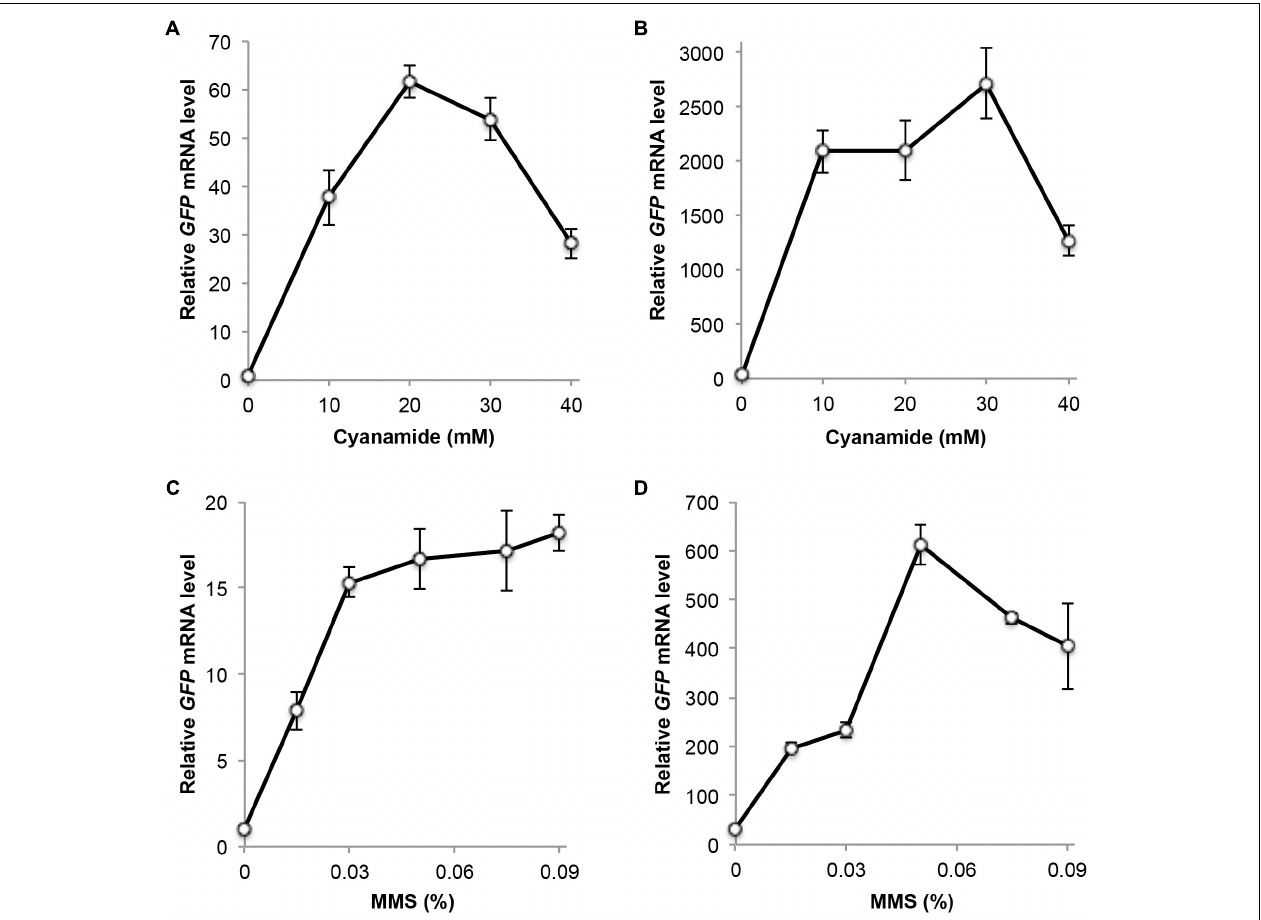
FIGURE 3 | Relative GFP transcript levels measured by qRT-PCR. (A) Cells harboring plasmid YCpU-P DDI2 − GFP in response to CY treatment. (B) Cells harboring plasmid